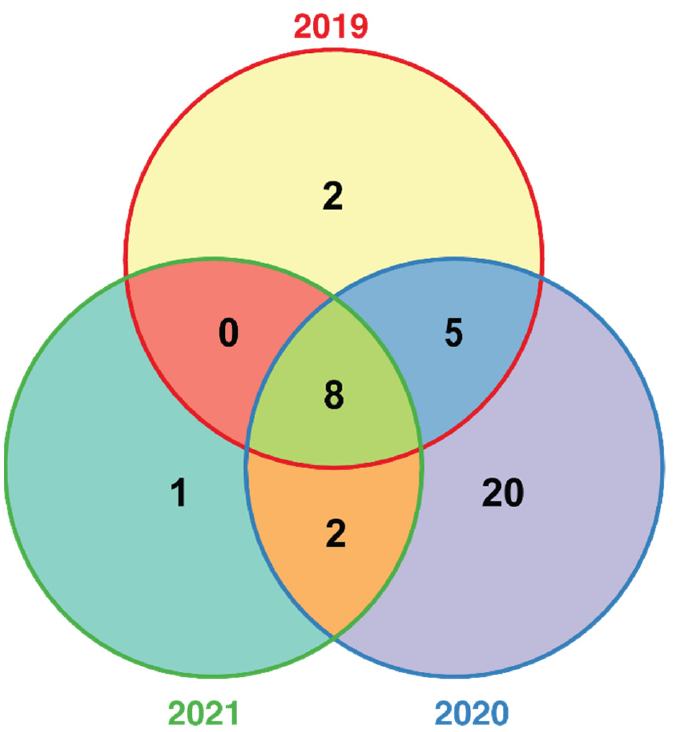
Figure 2. Venn diagram representing the number of unique and shared QTNs associated with DSI index in between-year comparisons.